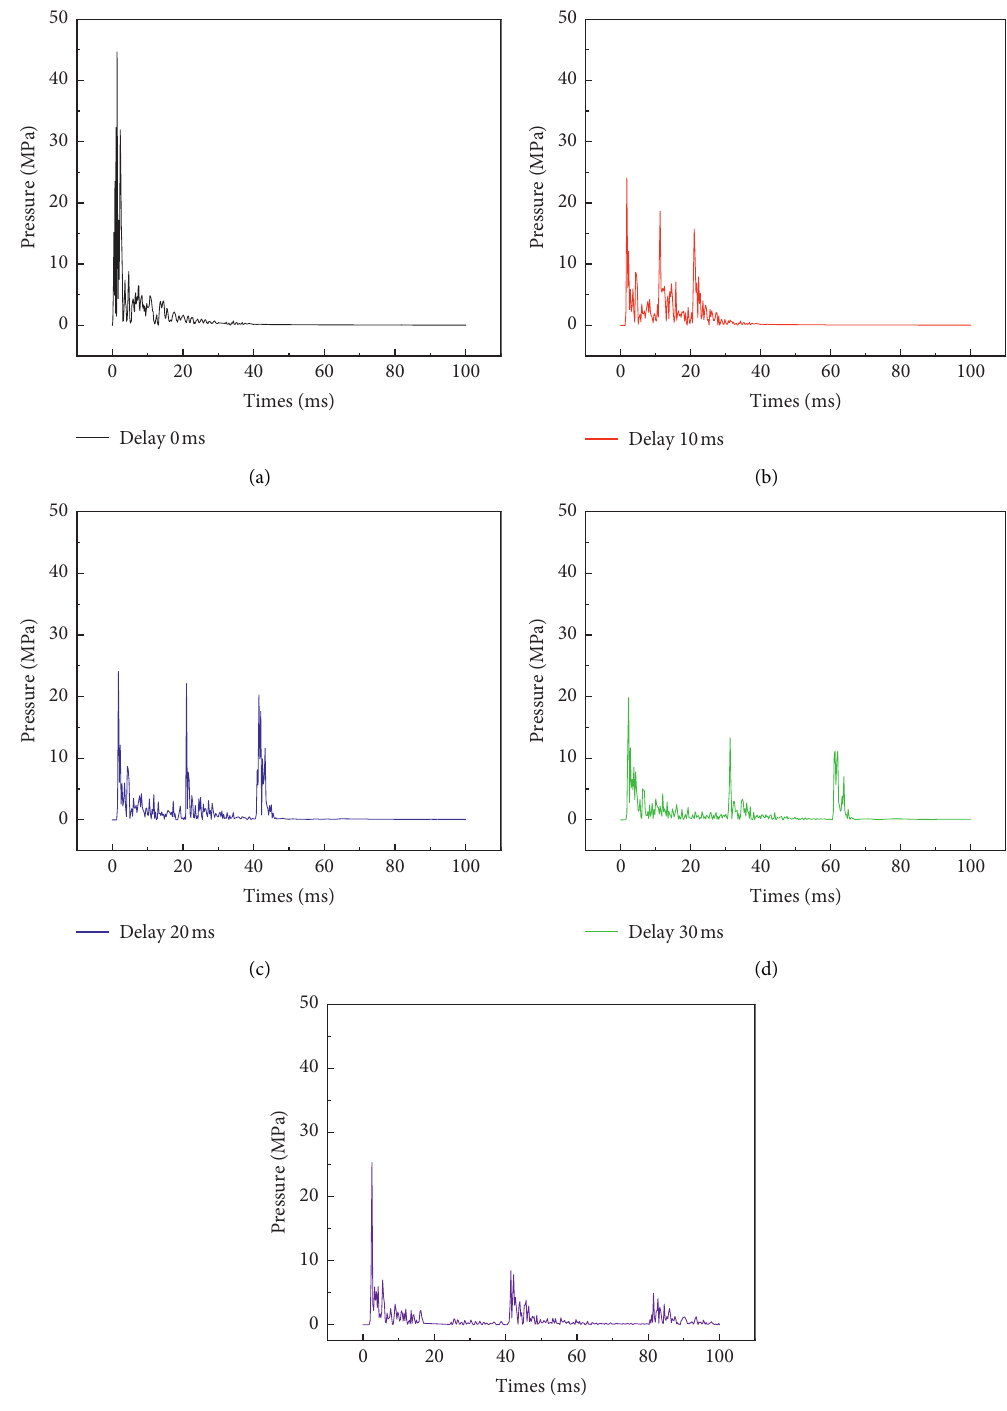
Figure 4: Typical unit pressure-time history curve. (a) Delay 0ms. (b) Delay 10 ms. (c) Delay 20ms. (d) Delay 30 ms. (e) Delay